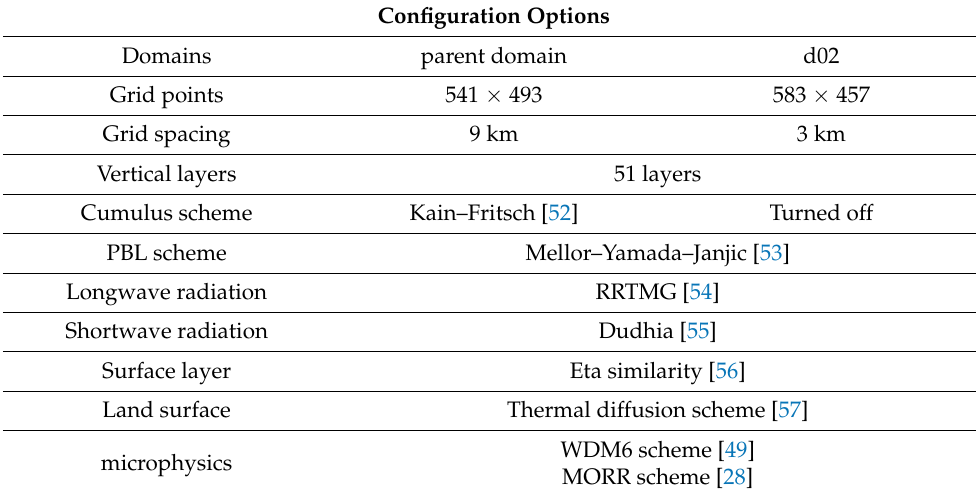
Table 1. Summary of WRF configuration